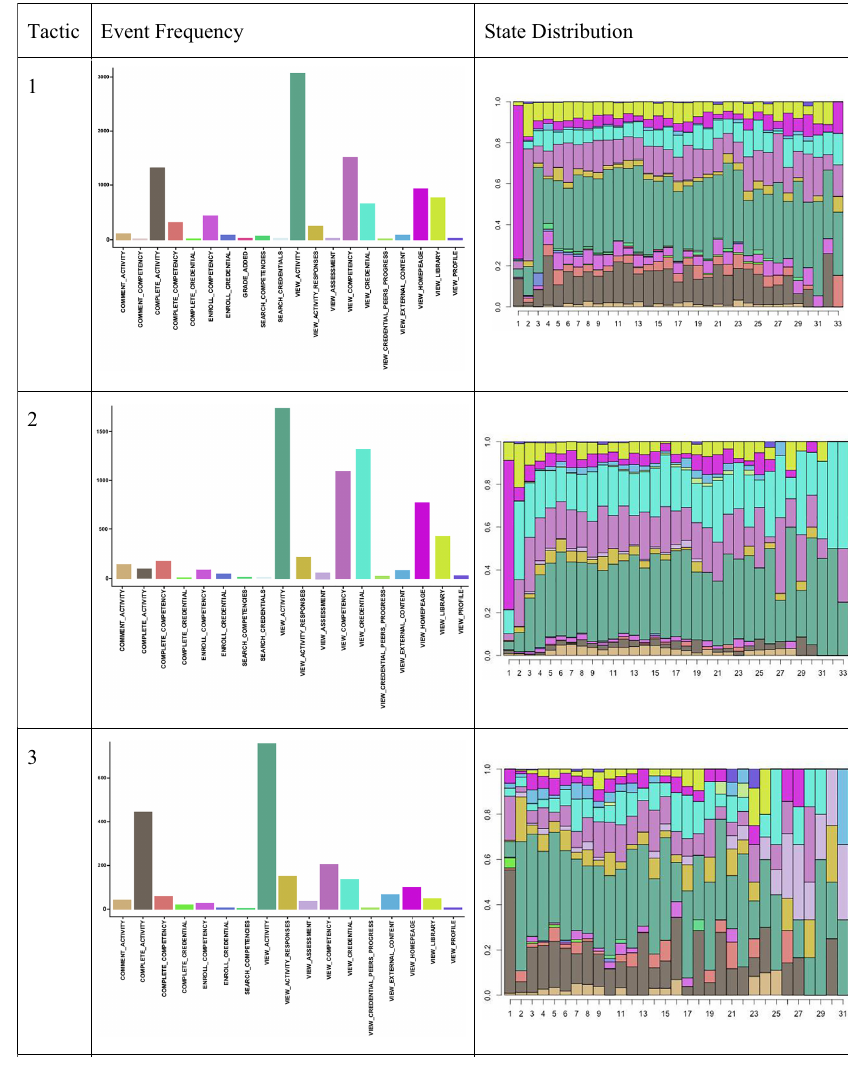
Table 1. Event frequency and distribution for detected